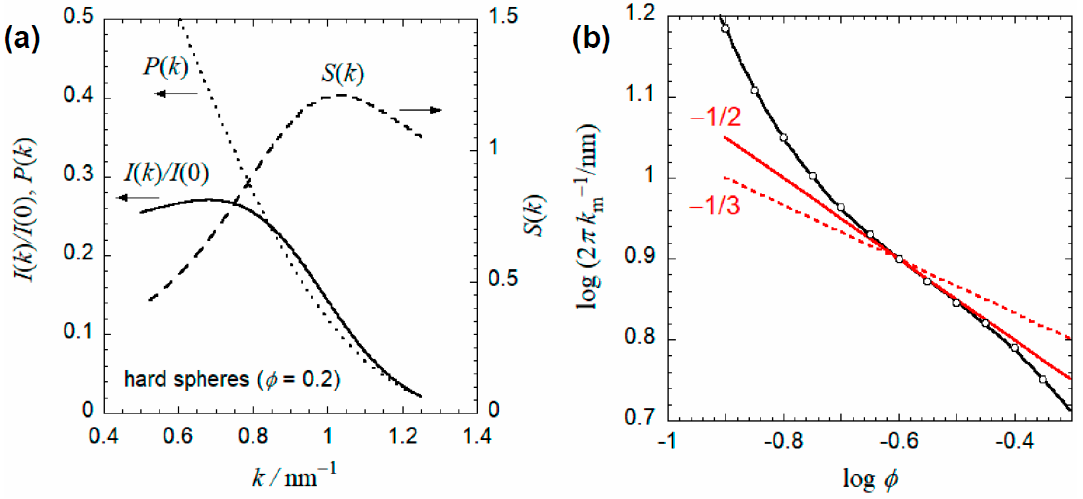
Figure A1. Double logarithmic plot of 2 π /k m vs. φ for hard sphere